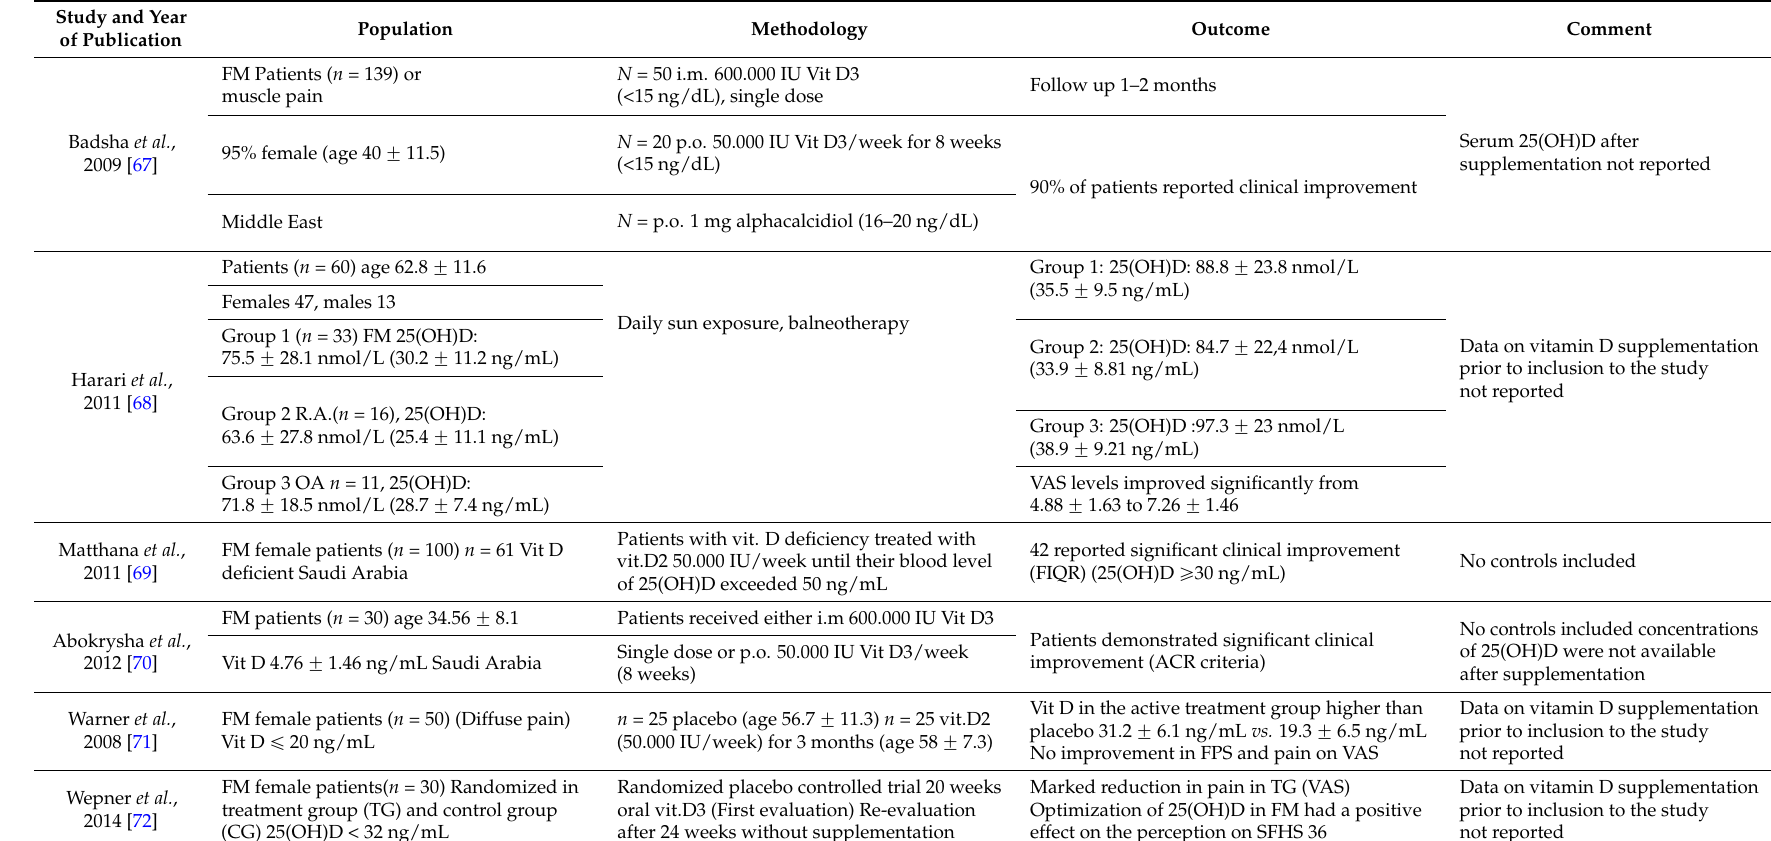
Table 2. Available vitamin D supplementation studies in